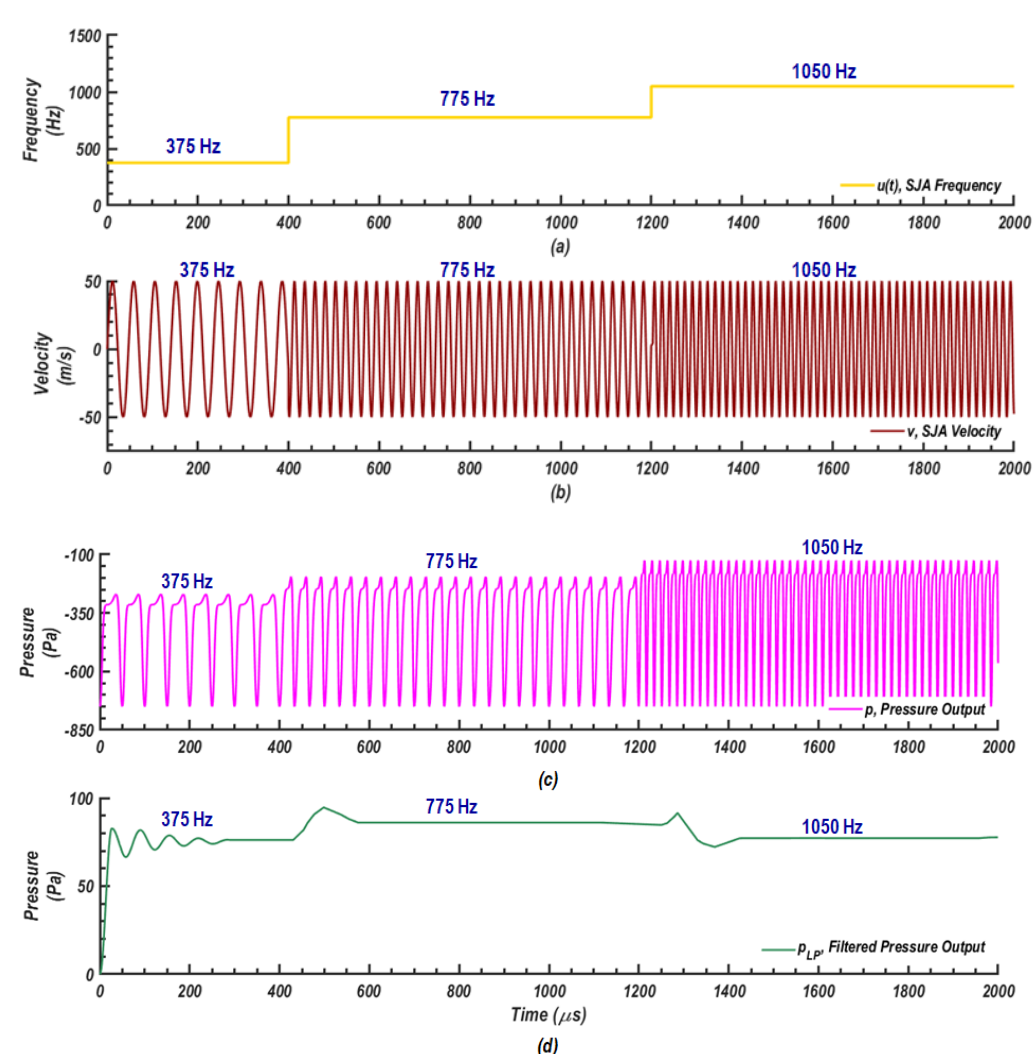
Figure 13. Schematic of an open-loop control system.